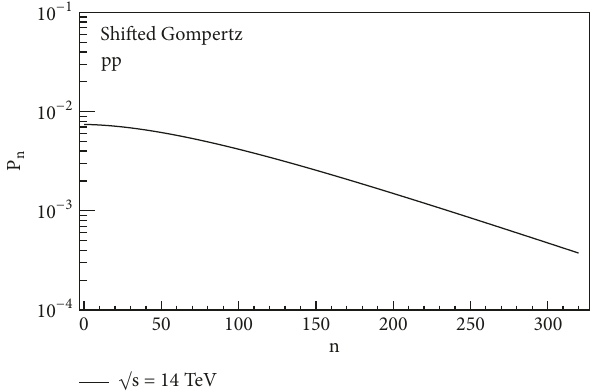
Figure 12: Probability distribution 𝑝𝑝 collisions predicted from shifted Gompertz